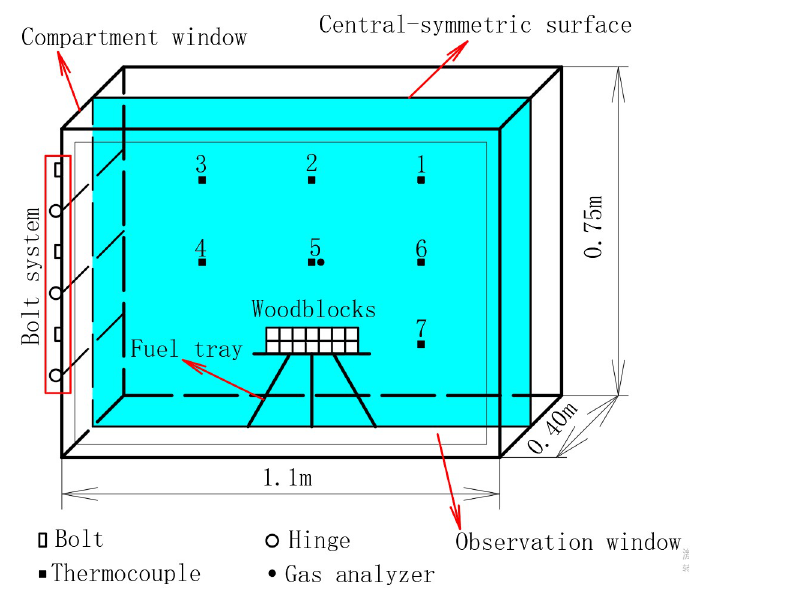
Fig 1. Model of the experimental